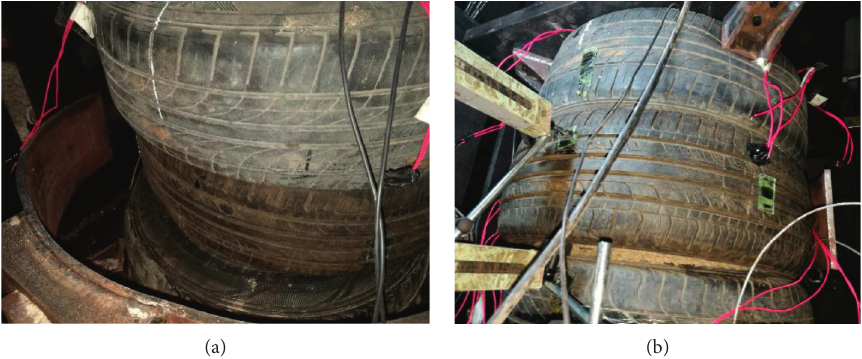
Figure 13: Failure state of specimen SD-8. (a) Misalignment between tires. (b) Sand leakage.